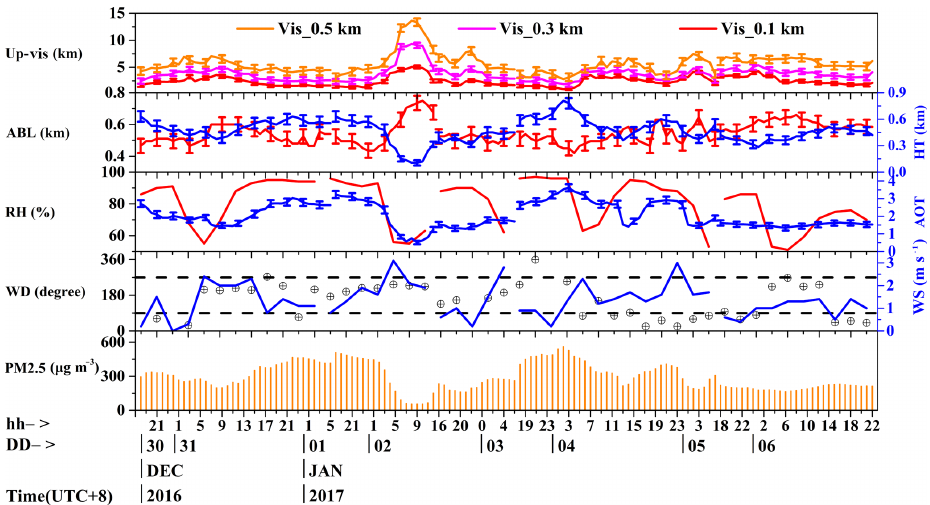
Figure 5. Hourly variation of multi-platform data between 30 December 2016 and 6 January 2017 in the northwest of downtown Beijing.